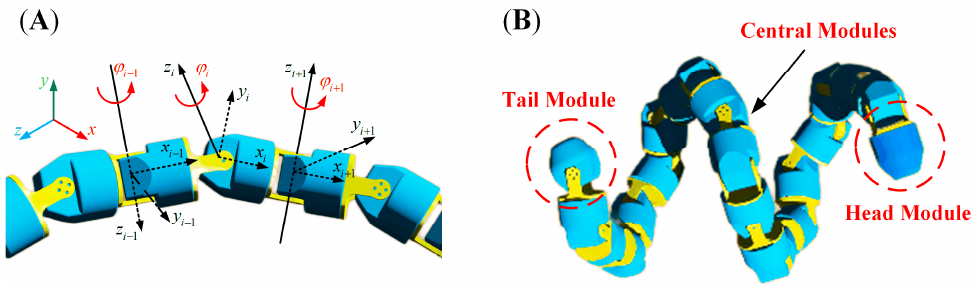
Figure 12. The snake-like robot with orthogonal joints: ( A )the joint modules are connected orthogo- nally; and ( B ) the snake-like robot is modeled by 20 modules which can be divided into head, tail, and central modules.